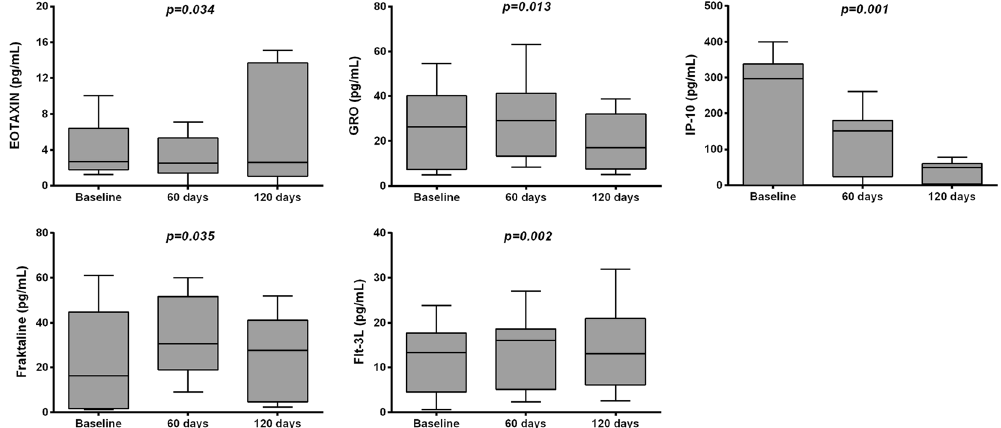
Figure 2. Box-whiskers graphs of Chemokines values at baseline and during the follow-up. Box-whiskers plots show the 25 th and 75 th percentile range (box) with 95% Tukey’s confidence intervals (whiskers) and median values (transverse lines in the box). The p-values in figure are relative to comparison of Chemokines levels among time.